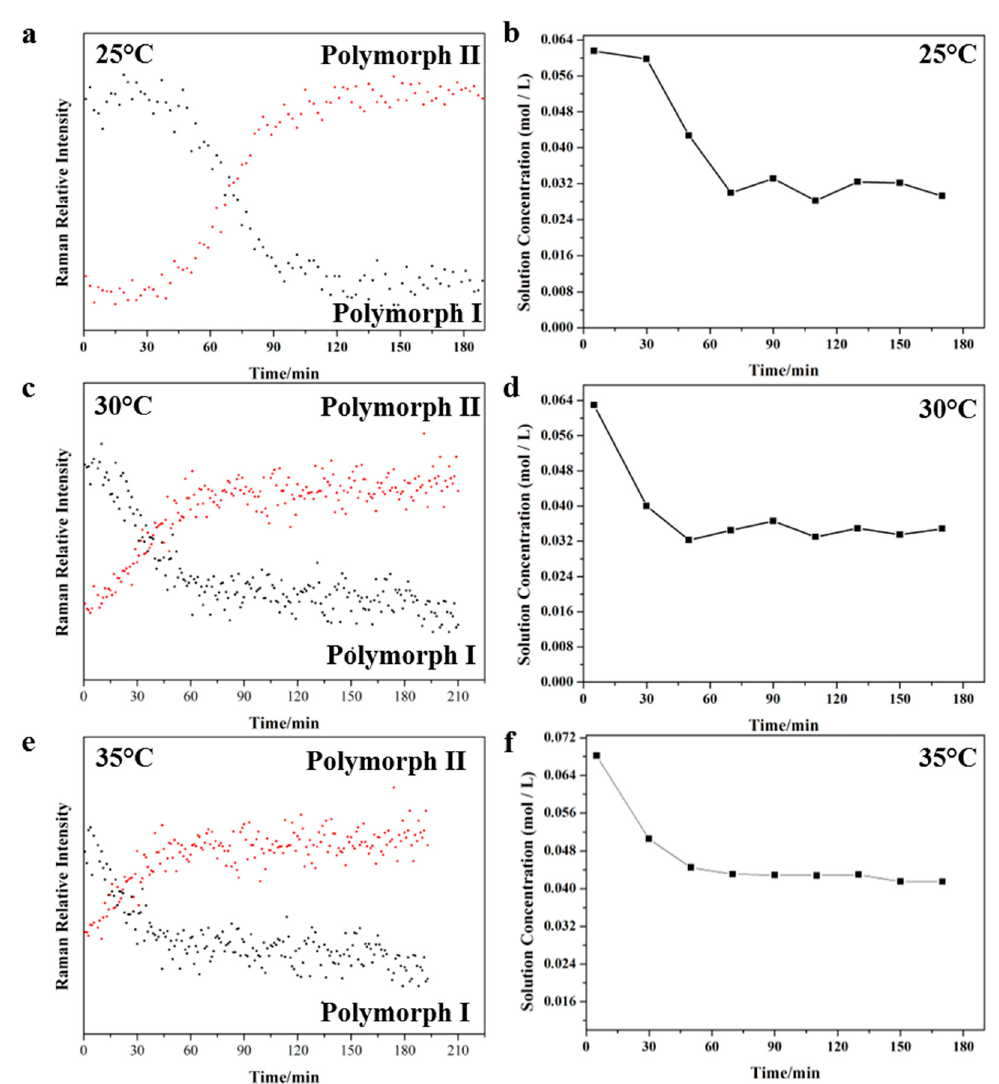
Figure 8. Solution-mediated polymorphic transformation between two polymorphs of theophylline in methanol at various temperatures. Profiles of solid composition at 25 °C, 30 °C, and 35 °C are shown in ( a,c,e ), respectively. ( b,d,f ) are their solution concentrations, respectively.